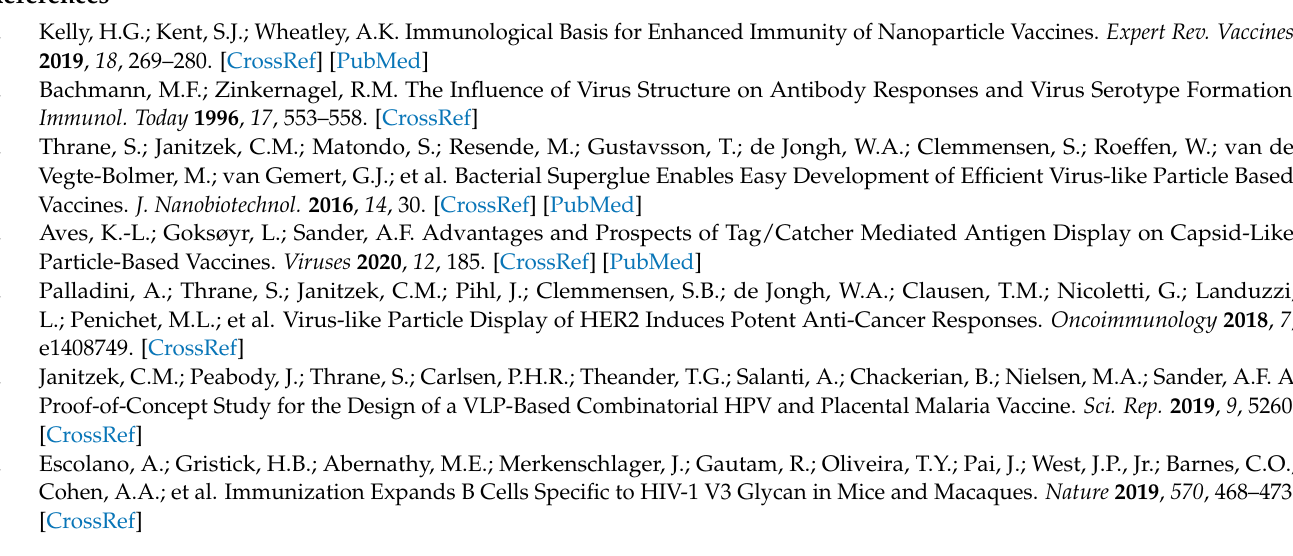
Quantitative dynamic-light scattering results of freeze-dried Catcher-cVLP, HAstem-cVLP, and RBD- cVLP. Table S5: Thermal stability of freeze-dried RBD-cVLP SARS CoV-2 vaccine (related to Figure 3E). Figure S1: Representative examples of the freeze-dried cake consistency. Figure S2: Effect of excipients on the stability of freeze-dried Catcher-cVLPs in a sodium phosphate buffer (pH 7.4). Figure S3: Effect of excipients on the stability of freeze-dried Catcher-cVLPs in a Tris buffer (pH 8.5). Figure S4: Stability of the Catcher-cVLP backbone after freeze-drying and storage for 2 months (Tris buffer). Figure S5: Effect of excipients on the stability of freeze-dried Tag-cVLPs in a sodium phosphate buffer (pH 7.4). Figure S6: Effect of excipients on the stability of freeze-dried Tag-cVLPs in a Tris (pH 8.5). Figure S7: Stability of the Tag-cVLP backbone after freeze-drying and storage for 2 months (Sodium Phosphate buffer). Figure S8: Stability of the Tag-cVLP backbone after freeze-drying and storage for 2 months (Tris buffer). Figure S9: Thermal stability of freeze-dried Tag-cVLP backbone. Figure S10: Freeze-drying of HAstem-cVLP influenza vaccine (related to Figure 2). Figure S11: Thermal stability of freeze-dried HAstem-cVLP influenza vaccine. Figure S12: Freeze-drying of RBD-cVLP SARS-CoV-2 vaccine (related to Figure 3). Figure S13: Six-month stability of freeze-dried RBD-cVLP SARS-CoV-2 vaccine at ambient temperature (related to Figure